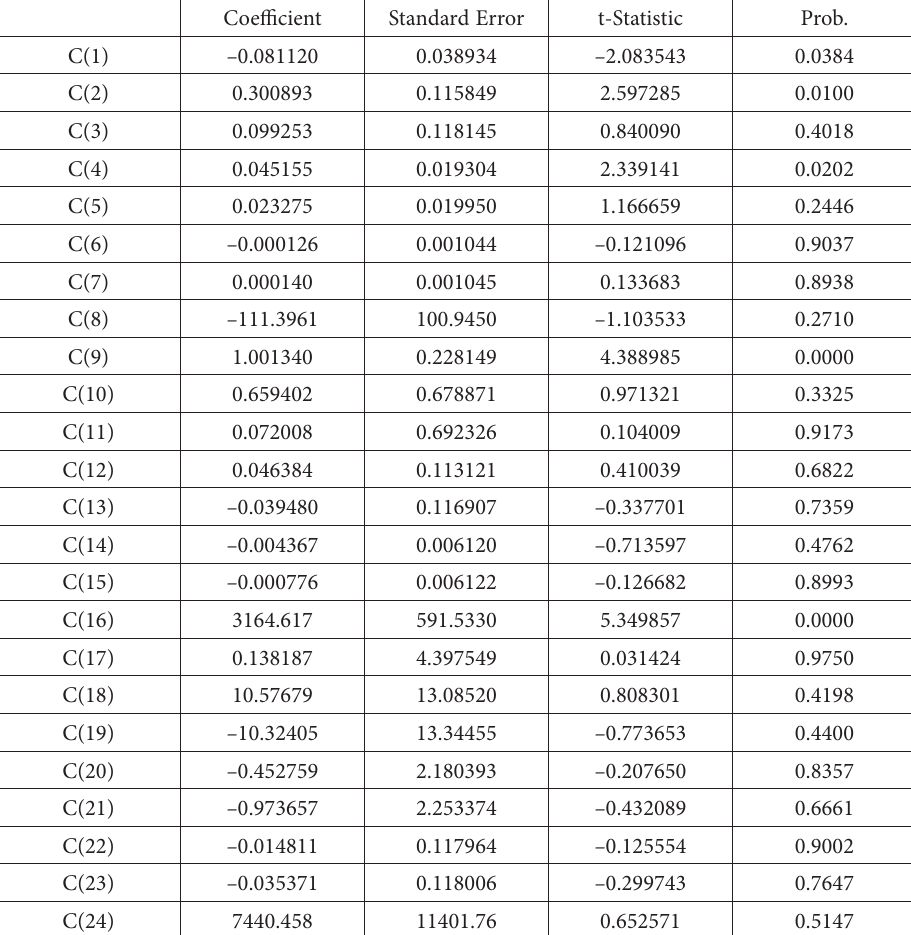
Table 6. The significance of the model’s coefficients for Romania (source: authors’ calculations) Coefficient Standard Error t-Statistic